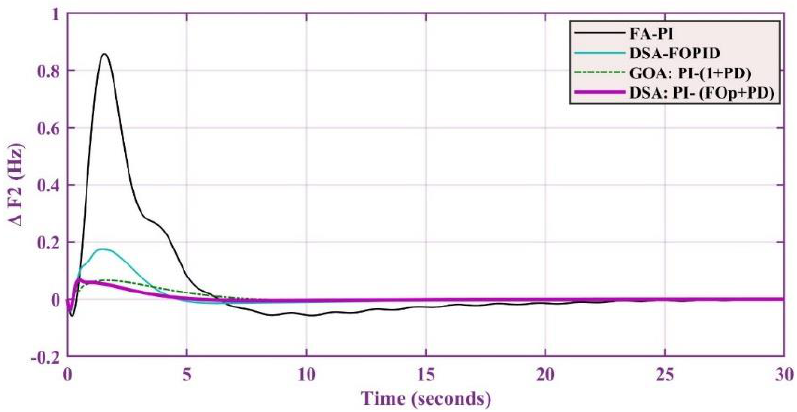
Figure 7. Response at 1% load change for area-2 .